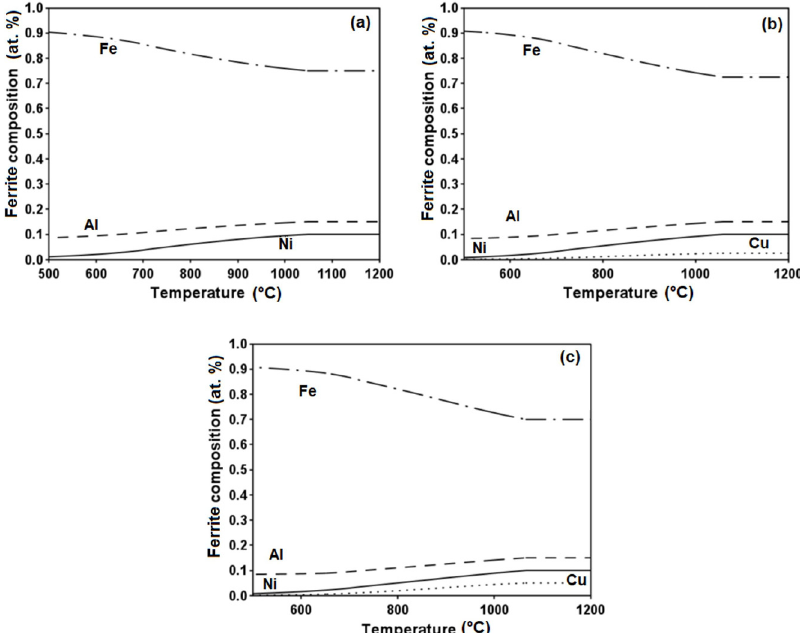
Figure 3. Plot of Calphad calculated chemical composition of the α ferrite phase versus temperature for (a) Fe-10at.%Ni-15at.%Al, (b) Fe-10at.%Ni-15at.%Al-2.5at.%Cu and (c) Fe-10at.%Ni-15at.%Al-5at.%Cu